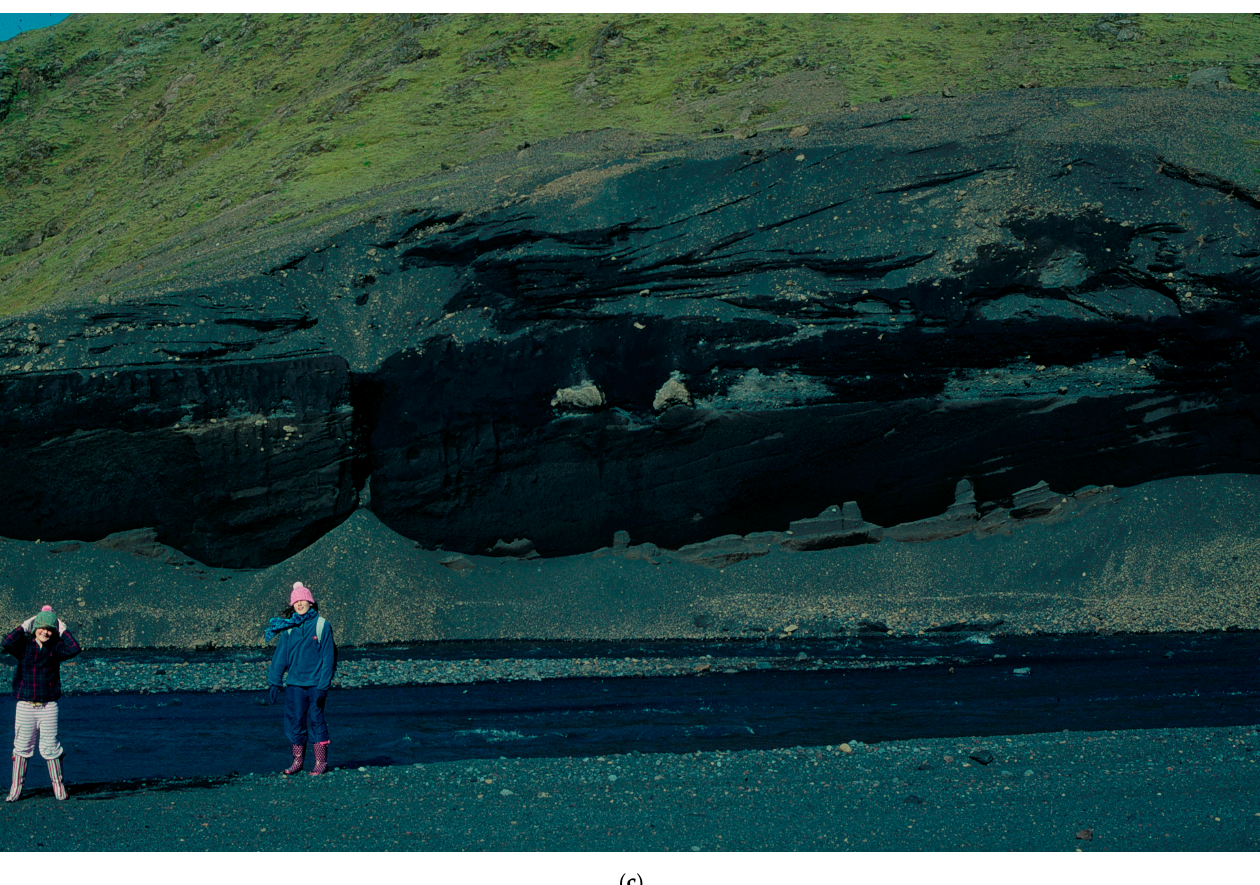
Figure 13. Glacifluvial features on the Oldufellsjökull eastern foreland and their relationships with the 50 m high bedrock cliff: ( a ) Aerial photograph extract (NERC ARSF 2007) showing the cliff, the LIA maximum moraine, the 934 AD jökulhlaup deposits, and inset channels demarcating early ice margin recession and containing dry waterfalls (DW); ( b ) Subglacially engorged eskers (EE) at the bedrock cliff base; and, ( c ) Superimposed foreset bedding separated by flood gravels with boulders and recording the sequential infilling and draining of an ice-dammed lake by “inwash” deltas in the valley dammed by the north edge of Oldufellsjökull (Lotte 10 and Tara Evans 12 for scale).